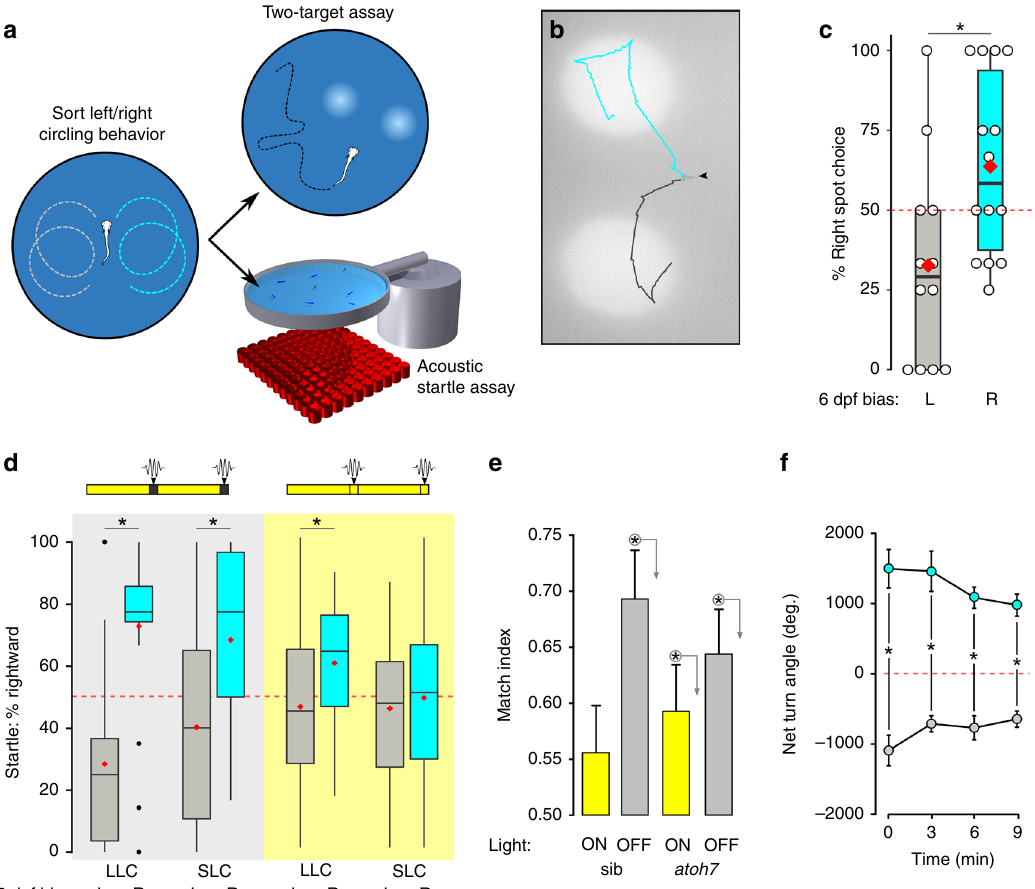
Fig. 2 Motor asymmetry is correlated across multiple behavioral tasks. a Experimental paradigm: larvae were classi fi ed as left-/right-biased at 6 dpf based on circling response after loss of illumination (over 4 trials). At 7 dpf, the same larvae were tested in either a two-target phototaxis assay or acoustic startle assay. b Representative path trajectories for right- (cyan) and left- (gray) classi fi ed larvae (arrowhead) presented with two symmetric light spots following loss of illumination. c Percent of trials on which larvae turned toward the right spot, for larvae classi fi ed at 6 dpf as left-biased (gray, N = 12) and right-biased (cyan bar, N = 13). Each larva performed four trials, with trials excluded if the larva was adjacent to the arena edge when light spots were presented. Asterisk p < 0.05, r = 0.51, Mann – Whitney U test. d Percentage of startle responses made in a rightward direction for larvae preclassi fi ed as left- (gray) or right- (cyan) biased. Larvae were tested either in the dark (gray background) or light (yellow background) conditions. As acoustic stimuli elicit either short- or long-latency C starts (SLC, LLC) that are mediated by different circuits, response types were analyzed separately. Red diamond indicates mean. Dark LLC responses: left N = 19, right N = 20. Dark SLC responses: left N = 12, right N = 14; light LLC responses: left N = 27, right N = 23; light SLC responses: left N = 18, right N = 28. Asterisk p < 0.05, r = 0.71, 0.51, and 0.35, respectively, Mann – Whitney U test. e Match index for atoh7 mutants and siblings during baseline illumination (sib, N = 45; mutant, N = 57; yellow bars) and dark conditions (sib, N = 51; mutant, N = 58; gray bars). Asterisk p < 0.05, r = 0.74, 0.20, and 0.41, respectively, one-sample permutation test to 0.5. f NTA for each of four trials after unilateral enucleation of the left (gray, N = 4) or right (cyan, N = 6) eye. Dotted red line: random output. Repeated measures ANOVA, the effect of side-lesioned, F 1,7 = 115.8, p < 0.001, η 2 = 0.94. Asterisk p < 0.05 between groups. Error bars represent standard error of the mean. Box plots show median and quartiles with whiskers p indicating 10 – 90%. Source data are provided as a Source Data fi